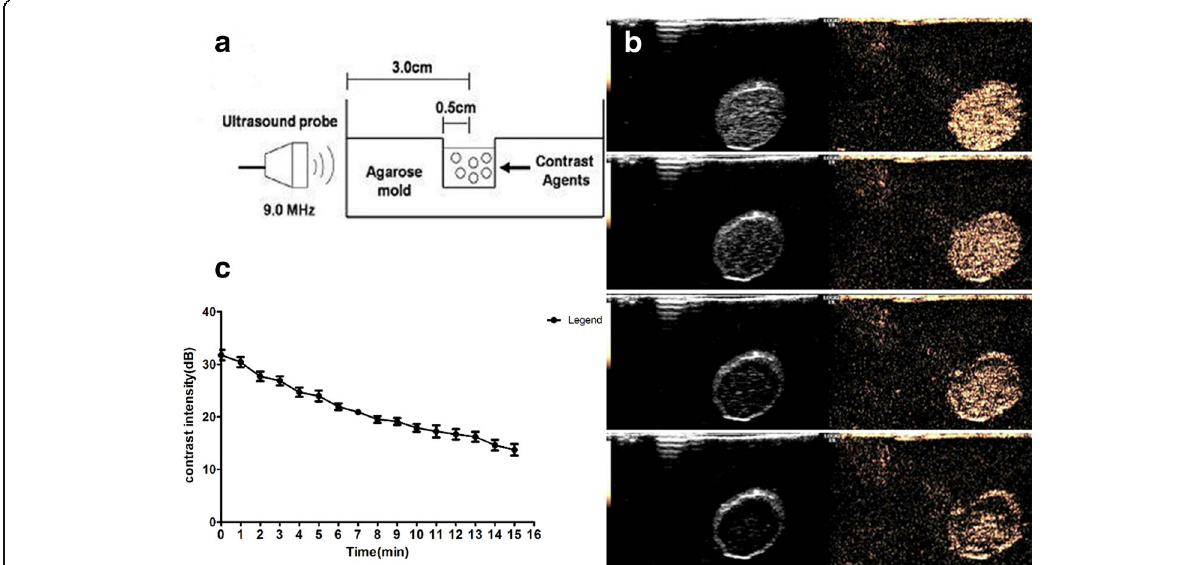
Fig. 5 A schematic illustration of the in vitro experimental setup ( a ), ultrasound images of DOX-loaded NBs (0, 5, 10, and 15 min) using a 9.0-MHz probe ( b ) and time-intensity measurements of ultrasonic-contrast and DOX-loaded NBs ( c )